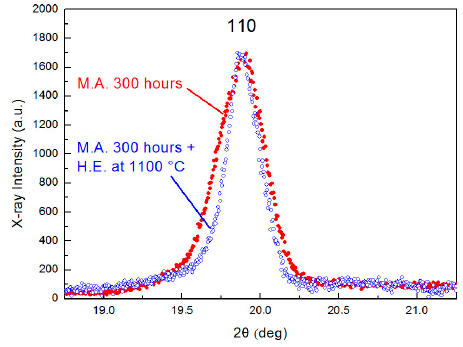
Figure 2. The {110} XRD peak profiles of the powder before and after hot